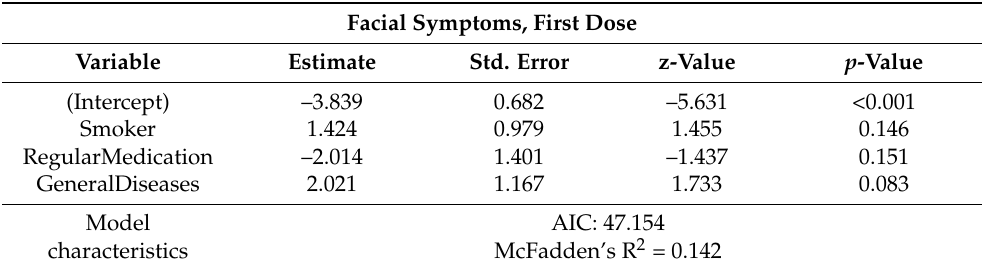
Table 6. Logistic model results for facial symptoms occurrence after first dose.